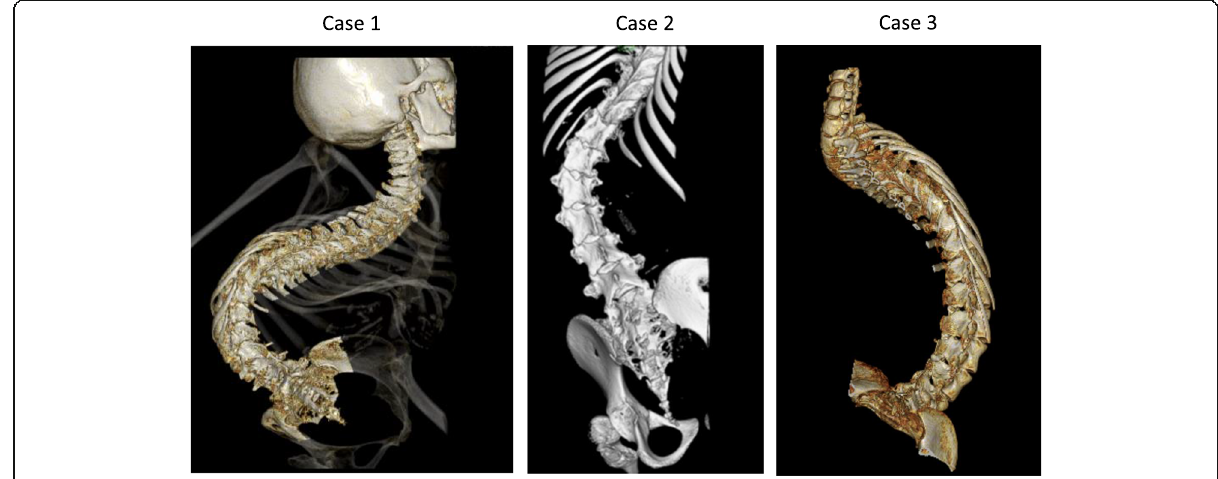
Fig. 1 Reconstructed three-dimensional CT images of three cases. The volume-rendering reconstructions show marked scoliosis